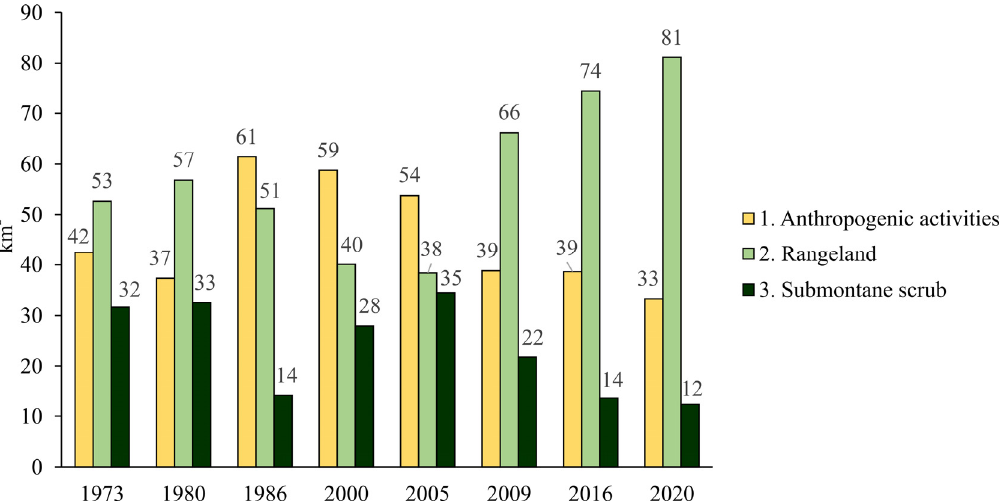
Figure 3. Land use coverage and changes in the study period, San Rafael, Tula, Tamaulipas, Mexico.